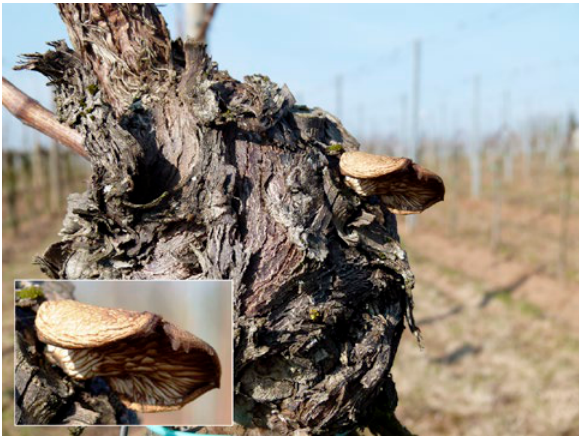
Figure 7. An old fruitbody of Pleurotus ostreatus , showing some drying on a living vine. Season is late winter. Photo - graph: M.